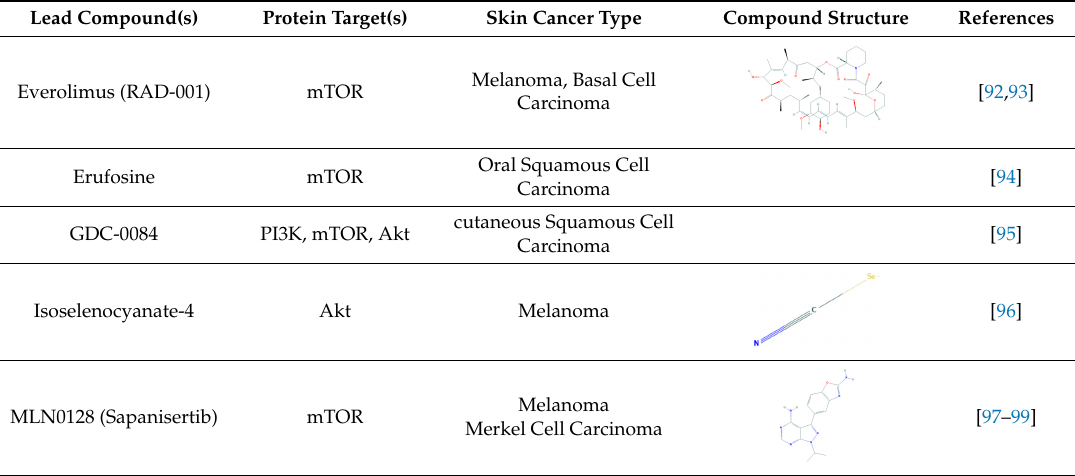
Table 1. List of reported lead synthetic compounds targeting mTOR, PI3K, and Akt signaling pathway in various skin cancers.